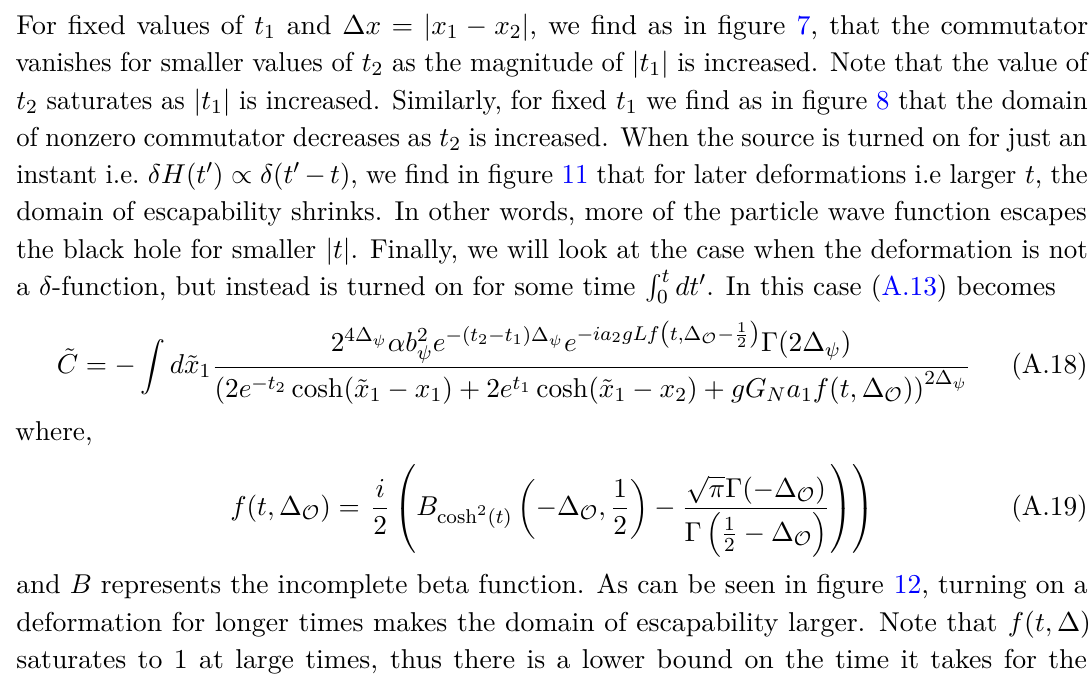
Figure 12 . x 2 6 = x 1 for a source that is turned for time 0 to t for some t 1 , t 2